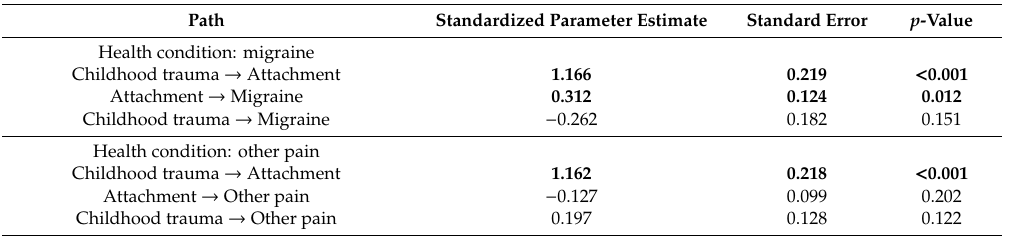
Figure 3. Mediation model between childhood trauma, adulthood attachment, and migraine, adjusted for sociodemographic variables. The mediation path coe ffi cients are highlighted in boldface. Note: Trauma = latent variable assessing childhood trauma, Attachment = latent variable assessing adulthood attachment; EA = emotional abuse, PA = physical abuse, SA = sexual abuse, EN = emotional neglect, PN = physical neglect; Anx = anxiety, Avoid = avoidance. *** p < 0.001, * p < 0.05. Table 5. Structural equation models (SEM) analyzing the indirect e ff ect of childhood trauma (CTQ) on reported adulthood health, mediated by adulthood attachment